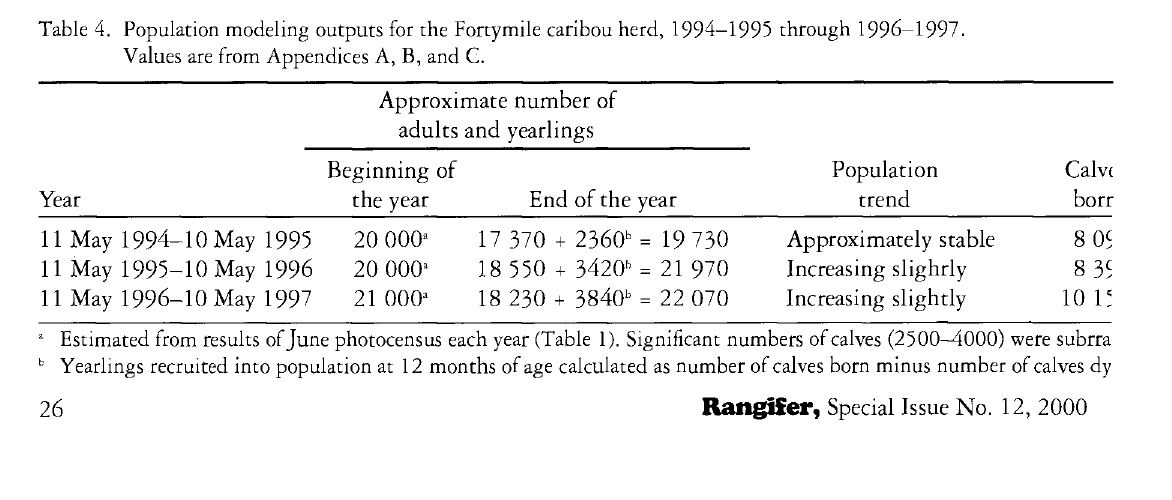
Table 4. Population modeling outputs for the Fortymile caribou herd, 1994-1995 through 1996-1997. Values are from Appendices A, B, and